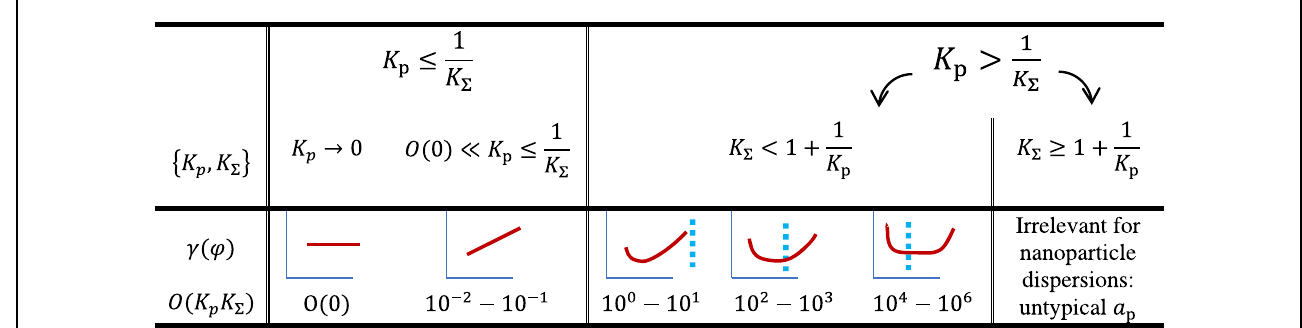
Table 6. Surface tension behaviours as function of K p (adsorption) and K Σ